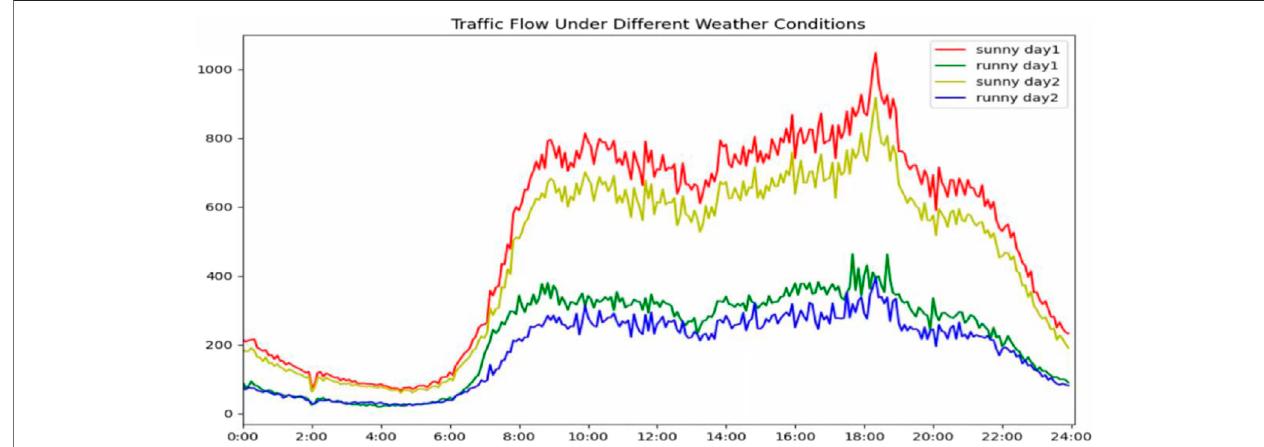
FIGURE 7 | Traf fi c fl ow under different weather conditions.